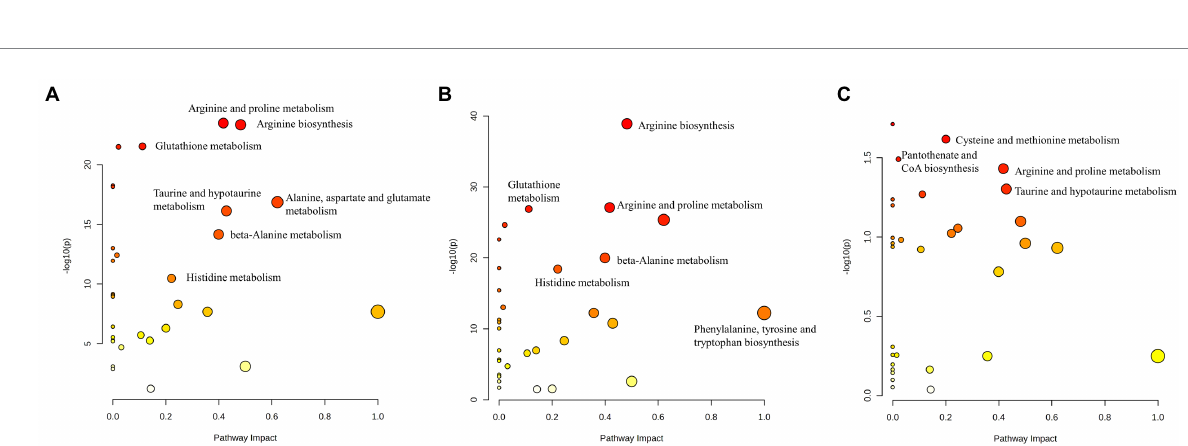
FIGURE 4 The control, MB, and MM groups were shown to differ significantly in several specific metabolic pathways. The influence on the relevant pathway was represented by node size, and the corresponding value of p from a pathway enrichment study was displayed by the node color. (A) MB vs. NC; (B) MM vs. NC; (C) MB vs.